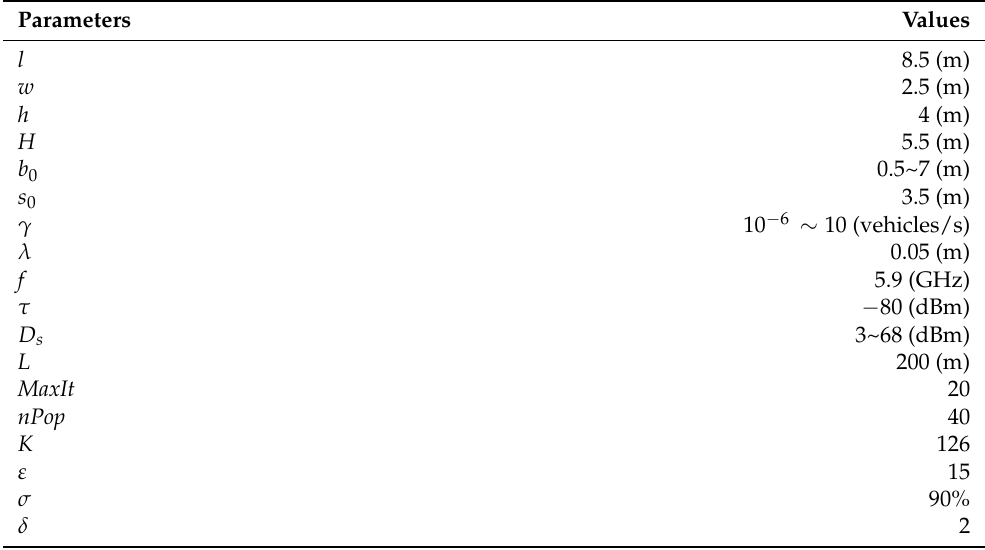
Figure 3. Two different maps and their simulation scenarios using real-life datasets: ( a ) map for London; ( b ) map for Manchester; ( c ) simulation scenario for London; ( d ) simulation scenario for Manchester. Table 2. Simulation